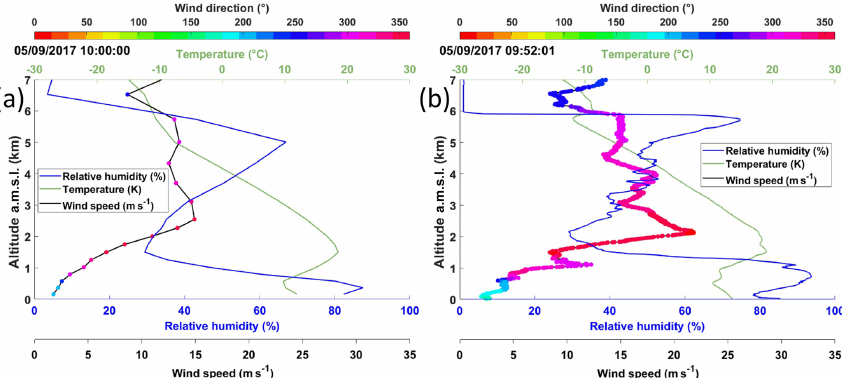
Figure 9. (a) Wind speed (solid black line), wind direction (coloured dots), RH (solid blue line) and temperature (solid green line) profiles extracted from ERA5 at 10:00UTC above Henties Bay over a 0.25 ◦ by 0.25 ◦ grid. (b) Same as panel (a) but measured by the dropsonde released over the ocean at 09:52UTC on 5 September